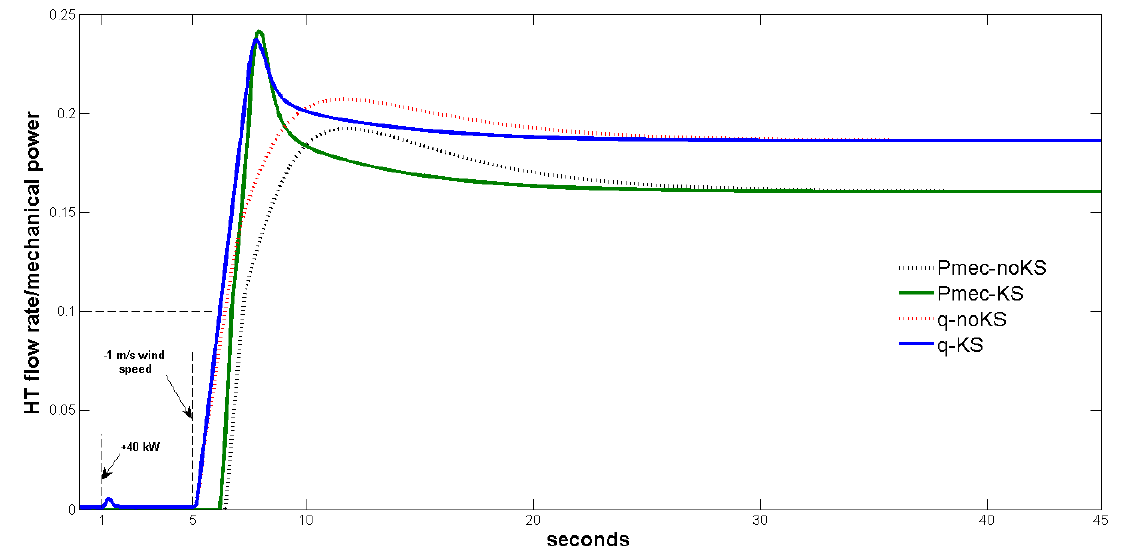
Figure 11. Hydraulic